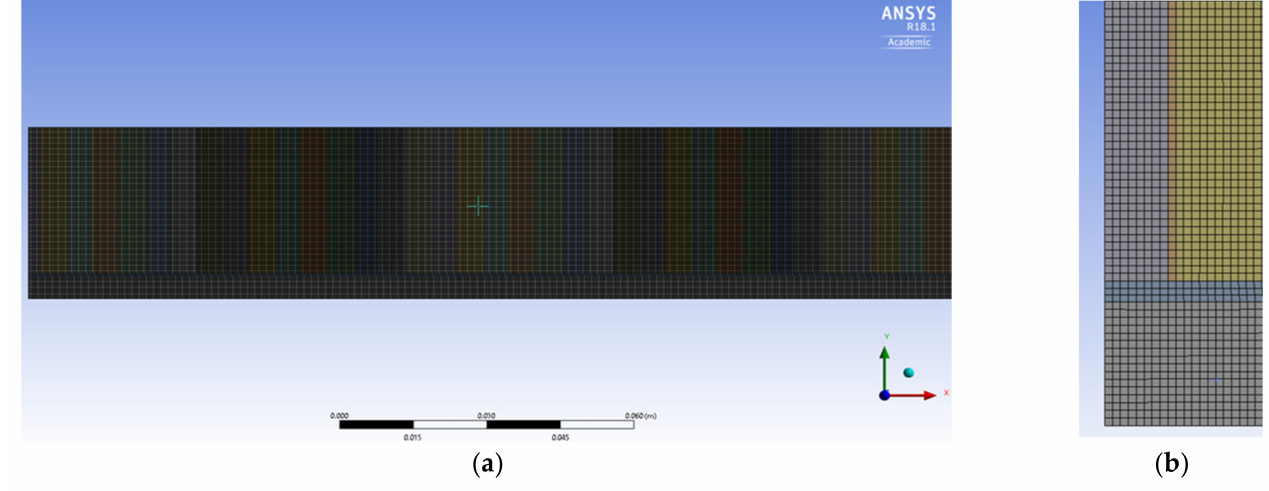
Figure 5. ( a ) Computational mesh of HE1 for charging; ( b ) enlarged view of the mesh.